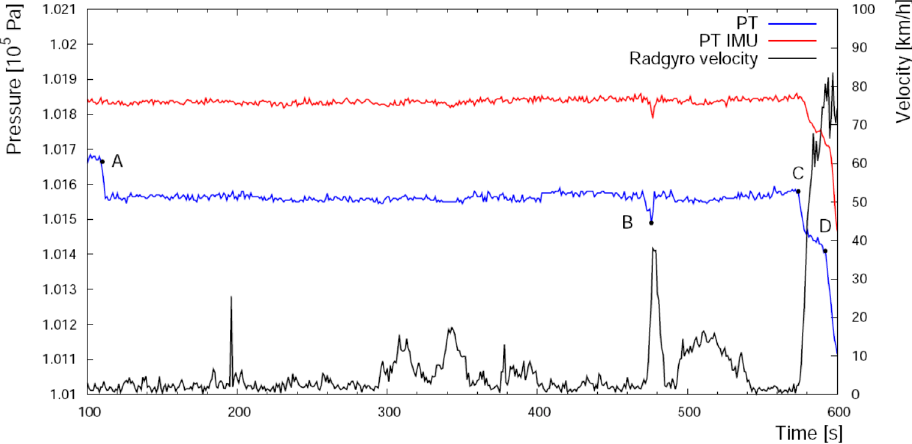
Figure 9. Temporal profile of the pressure measured by PT (in blue) and PTIMU (in red) not calibrated, and of the Radgyro horizontal velocity (in black) before the take-off. When the back screw is turned on, the PT sensor, which is significantly exposed to the air flux, measures a depression (point A). The pressure variation registered by both sensors in B is due to the rapid increase of velocity during the taxiing. The accelerating run along a runway starts in C and in D the aircraft takes off.